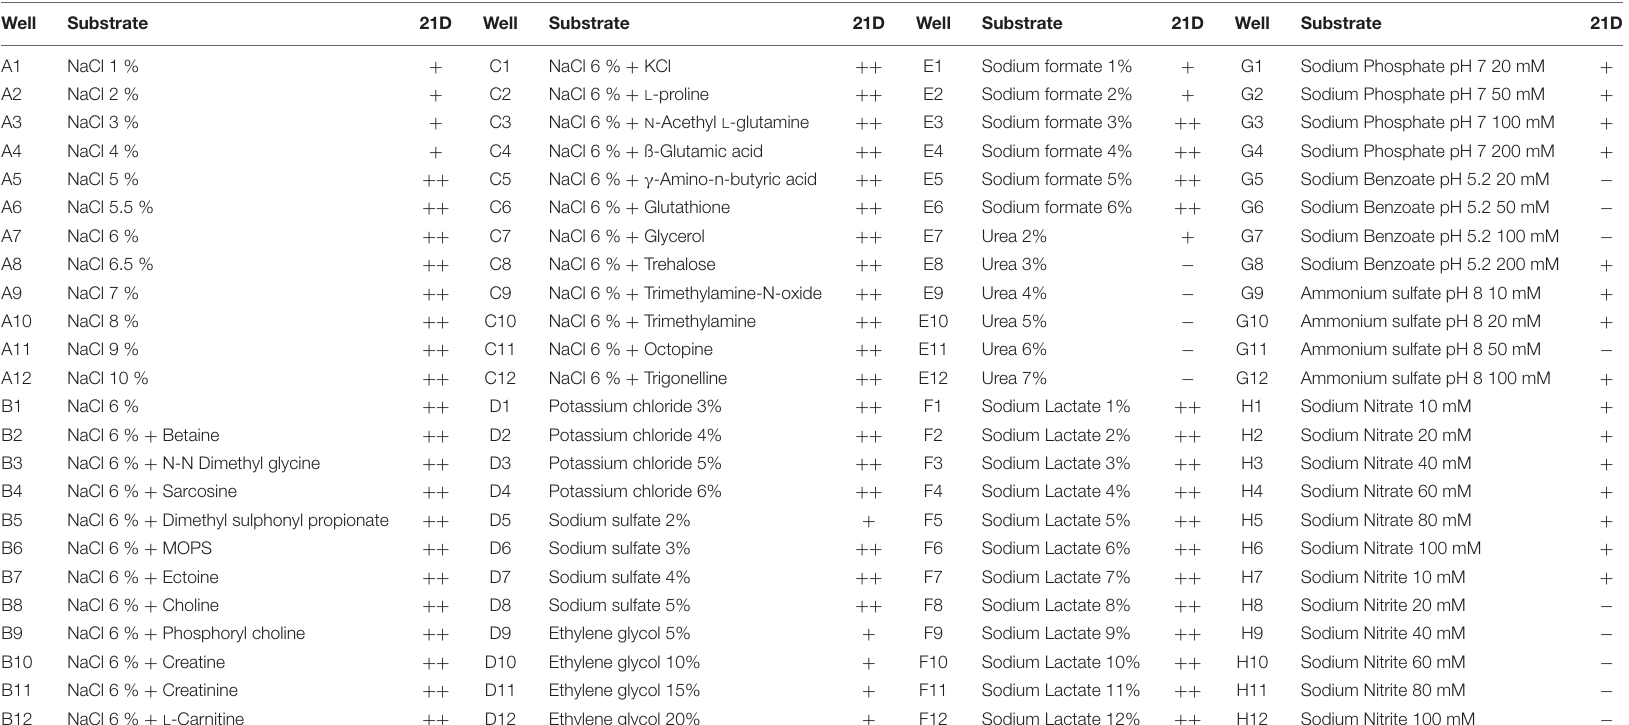
TABLE 3 | Metabolic profiling of V. dokdonensis strain 21D on Biolog PM 9 MicroPlate.